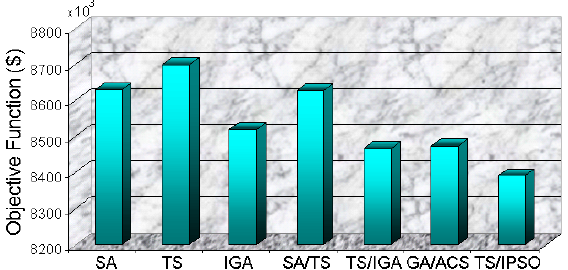
Figure 9. Comparison of the proposed algorithm with other modern algorithms in case 3.